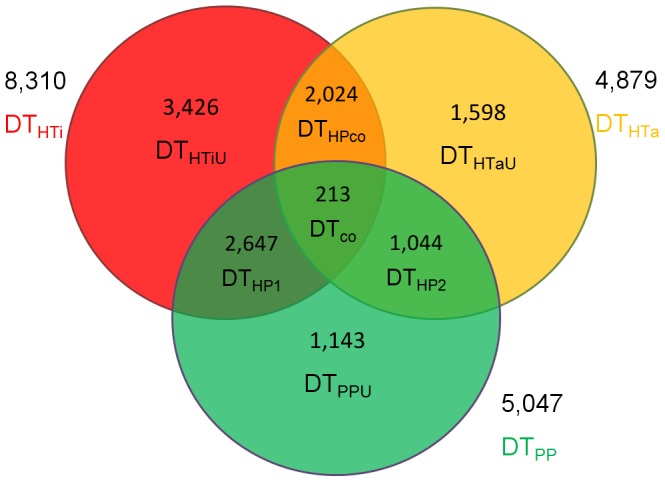
Grouping of differentially expressed transcripts.DTHTi, DTHTa and DTPP referred to DT from Jiyan-1 versus tiger puffer, Jiyan-1 versus tawny puffer, tiger puffer versus tawny puffer. DTHTiU, DTHTaU and DTPPU represented DT unique in corresponding groups. DTHP1, DTHP2 and DTHPco were DT found in both two groups (DTHTi+DTPP, DTHTi+DTPP and DTHTi+DTHTa, respectively). DTco were DT found in all three comparisons.